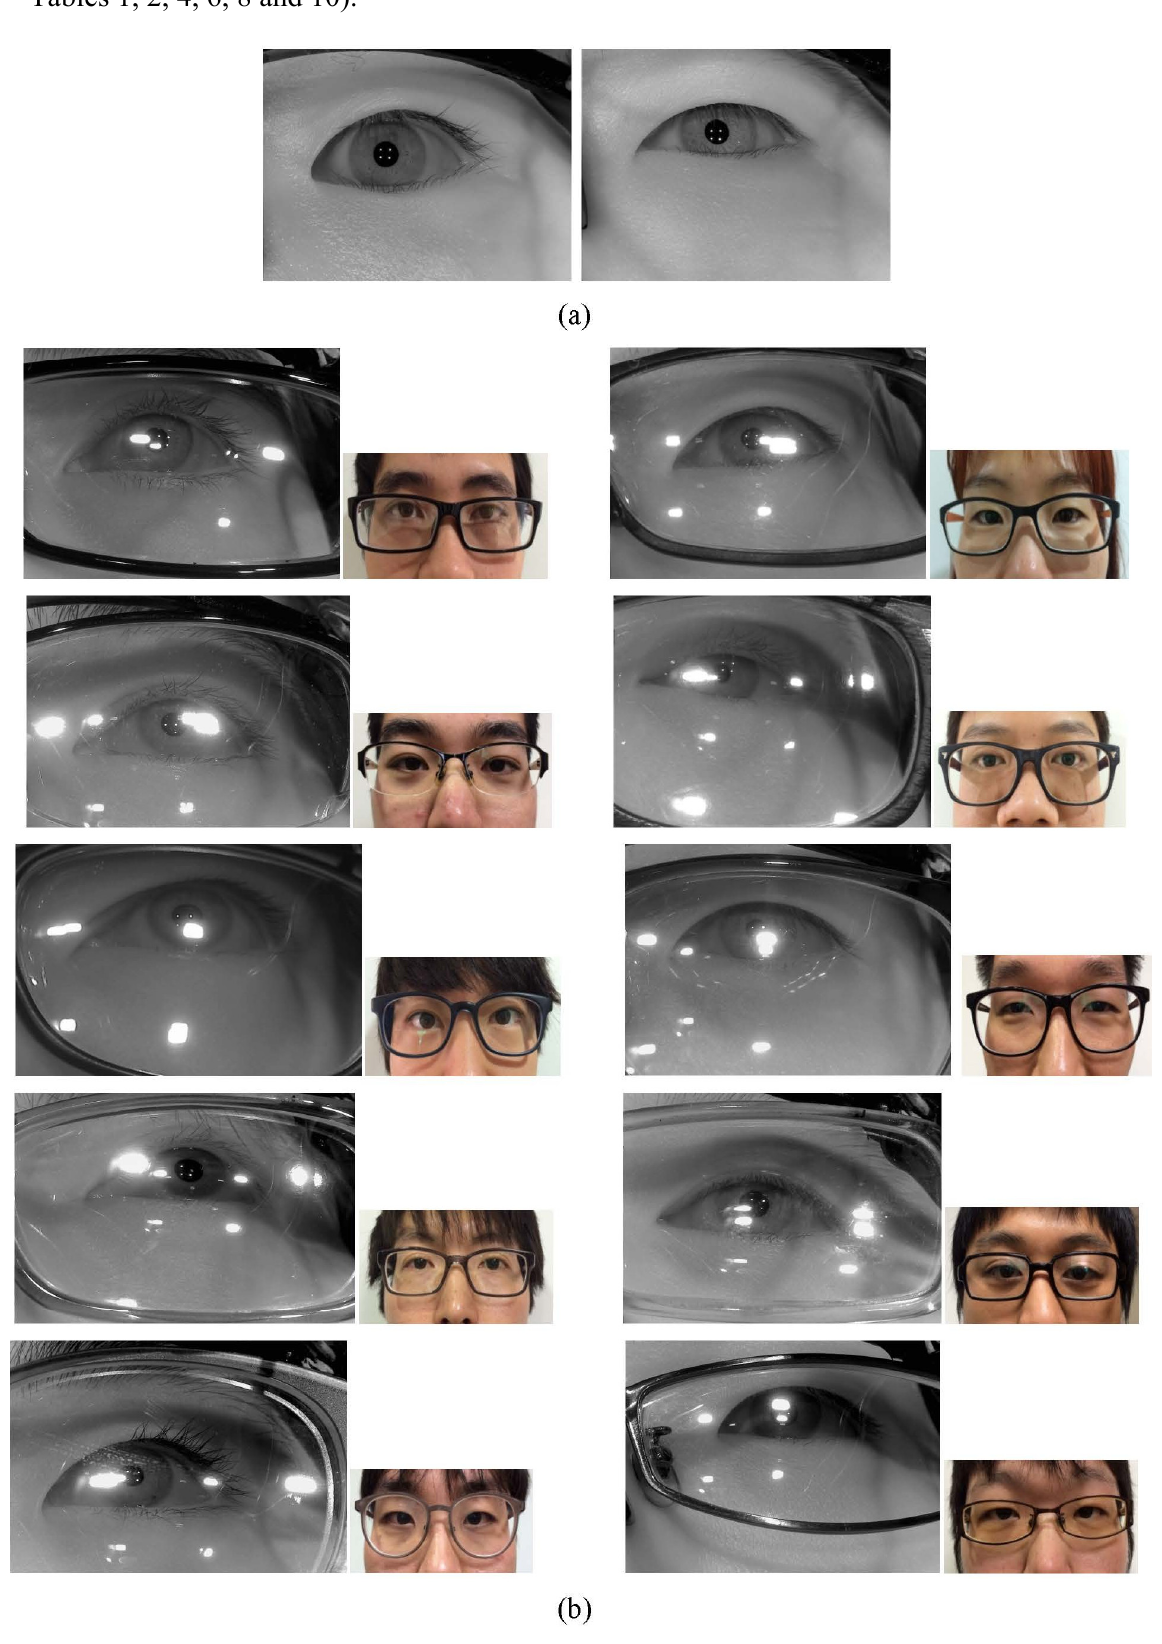
Figure 11. Examples of the images for experiments ( a ) Images of people not wearing glasses ( b ) Images of people wearing glasses (The top-left image is from user 1, the top-right image is from user 2, and the bottom-right image is from user 10 from Tables 1, 2, 4, 6, 8 and